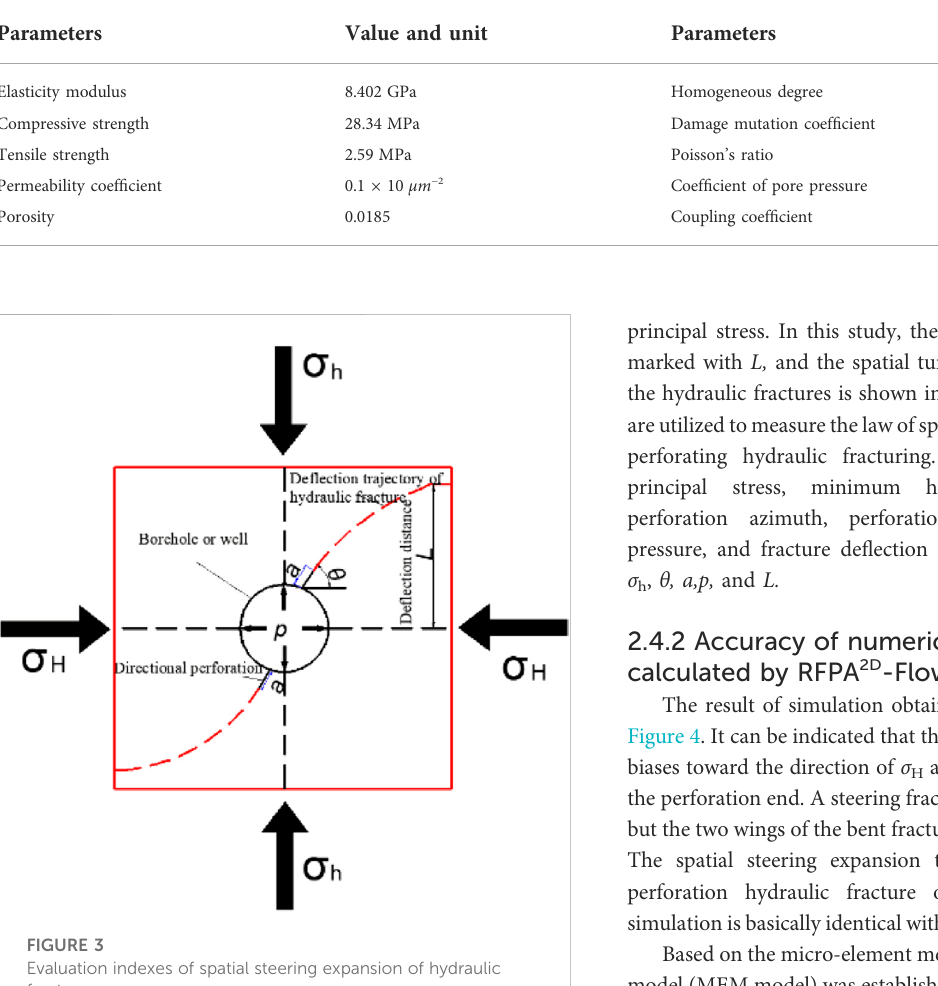
TABLE 2 Parameters of numerical simulation.